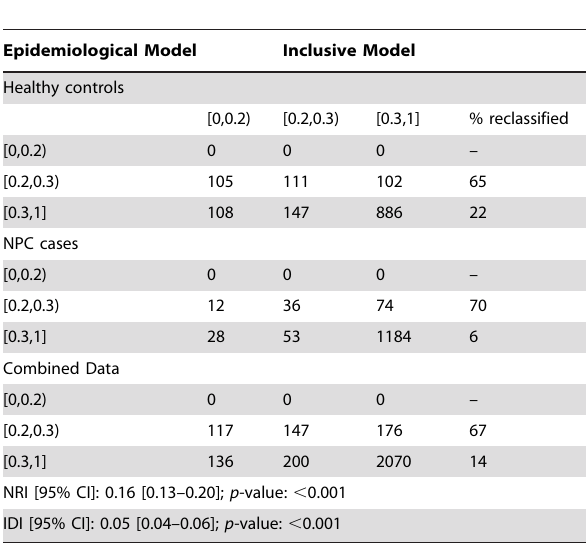
Table 4. Reclassification of data for use in epidemiological and inclusive models a